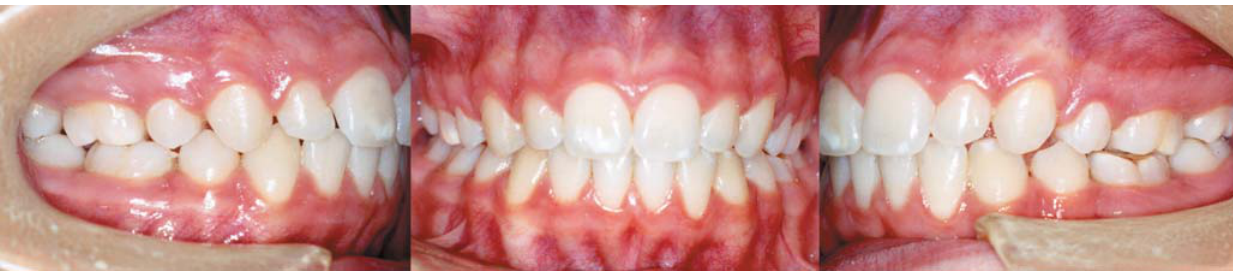
FIGURE 6- Frontal and lateral views at the end of treatment